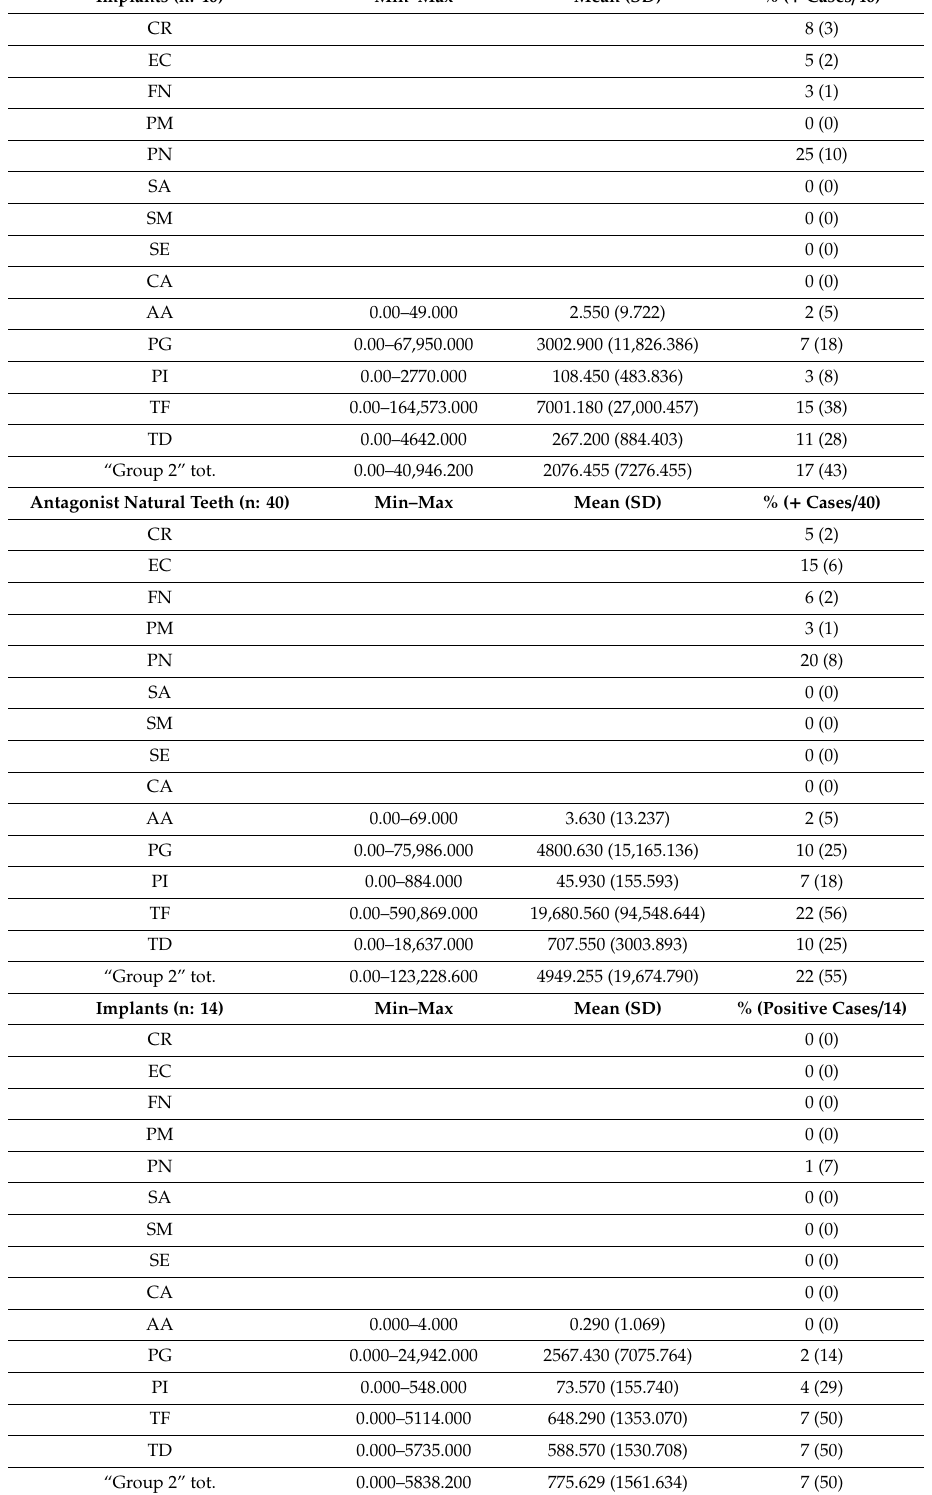
Table 2. Assessment of the microorganisms around CBP implants and antagonist natural teeth and